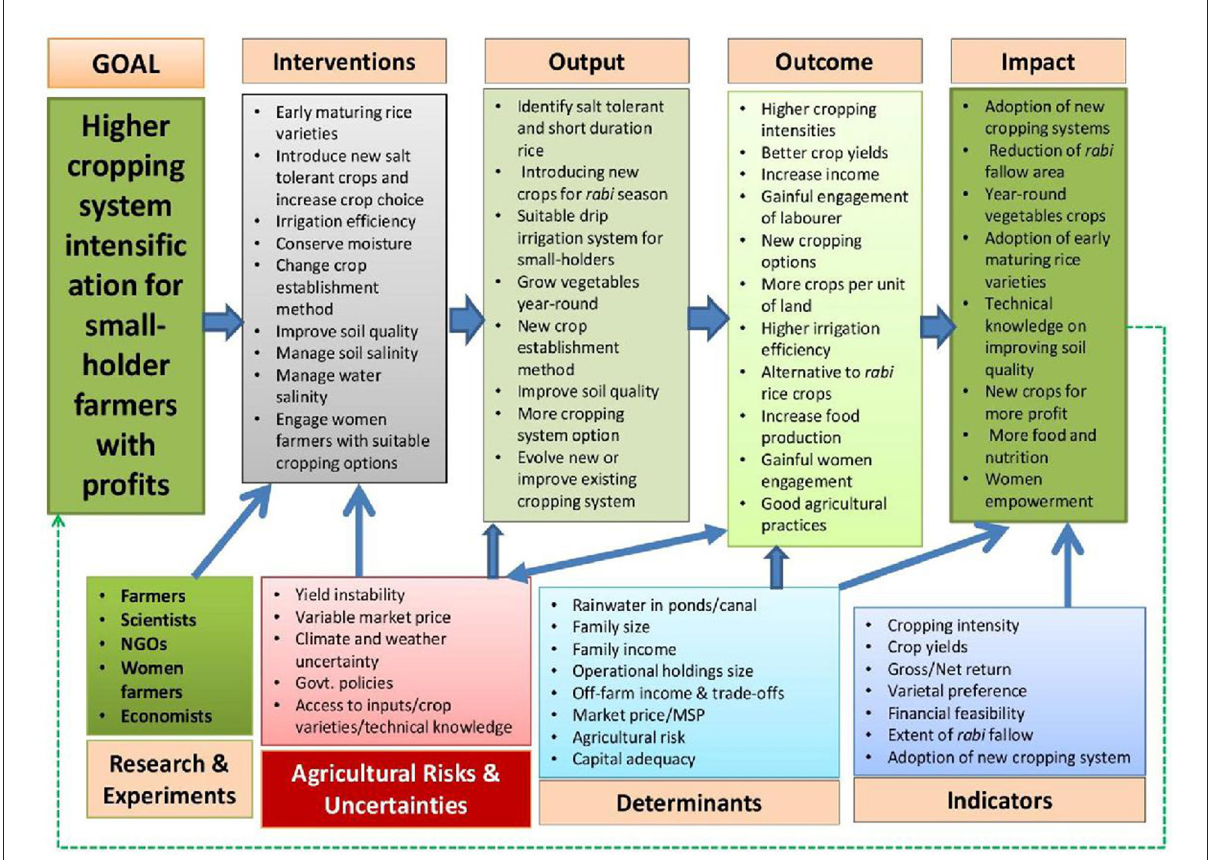
FIGURE2 Framework for cropping system intensification interventions and